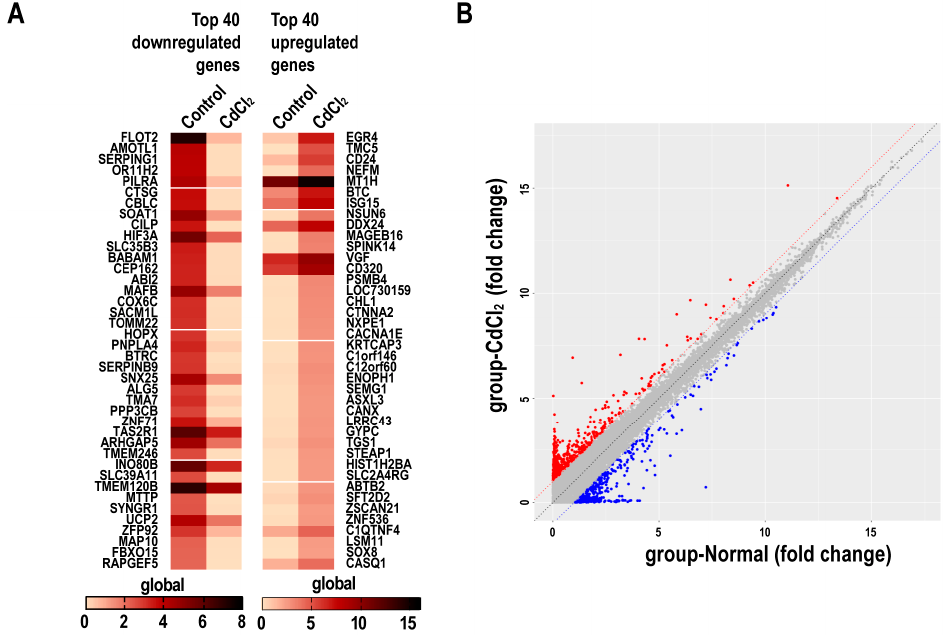
Figure 4. The effects of cadmium on mRNA expression profiles. BMMSCs were exposed to 0 or 0.2 µM CdCl 2 for 24 h, and a mRNA microarray was accomplished with control BMMSCs and CdCl 2 -BMMSCs according to the standard protocols of Arrayster. ( A ) A heat map of the 40 down-regulated and 40 up-regulated mRNAs in control BMMSCs and CdCl 2 -BMMSCs. ( B ) The scatter plots were for variation of expression of mRNAs between control BMMSCs and Cd-BMMSCs.